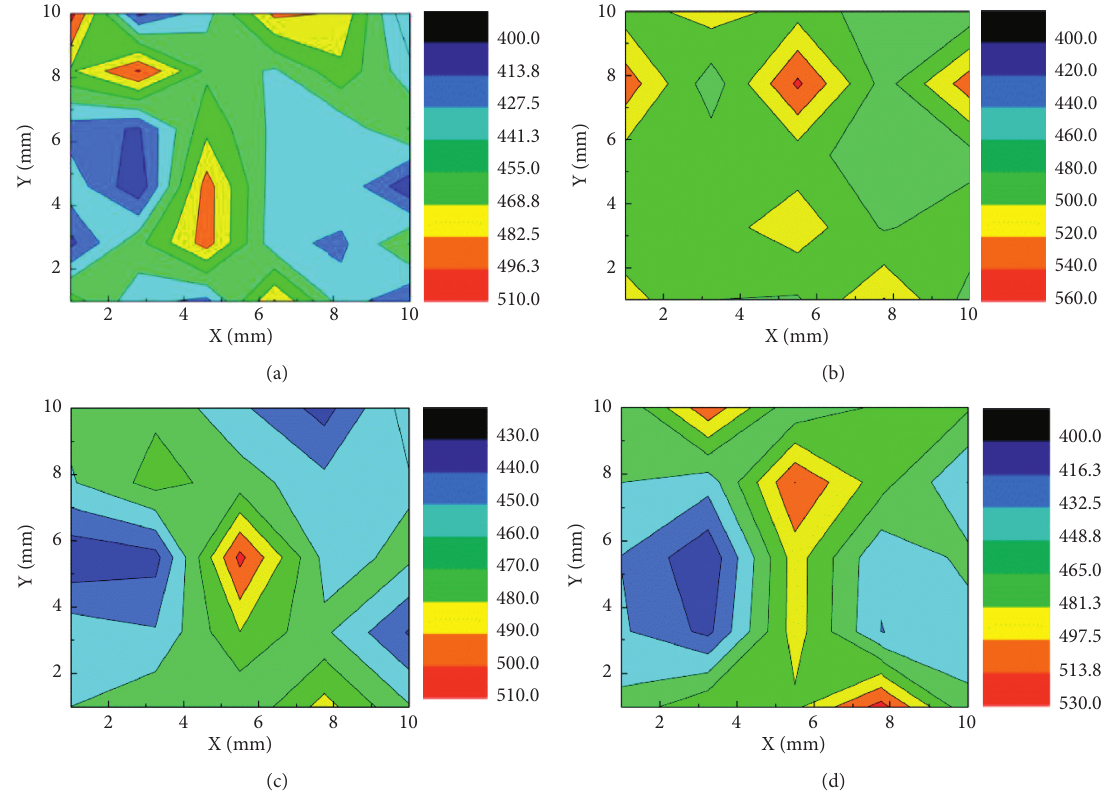
Figure 15: Hardness distribution of positions A, B, C, and